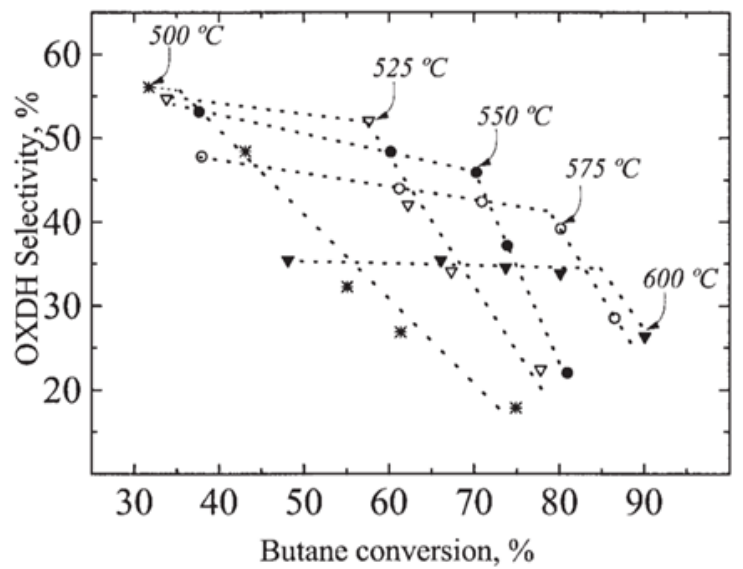
Figure 9. Selectivity-conversion plot for several temperatures of BDH catalysed over V/MgO in the ICFBR (interconnected fluidized-bed reactor). The mathematical model of the ICFBR with included kinetic and fluid dynamic model of the reaction was used. It shows that for a given temperature, the ODH selectivity decreases with butane conversion, gradually at first and more steeply later. (Reprinted with permission from [53]. Copyright 2004 John Wiley and Sons, American Institute of Chemical